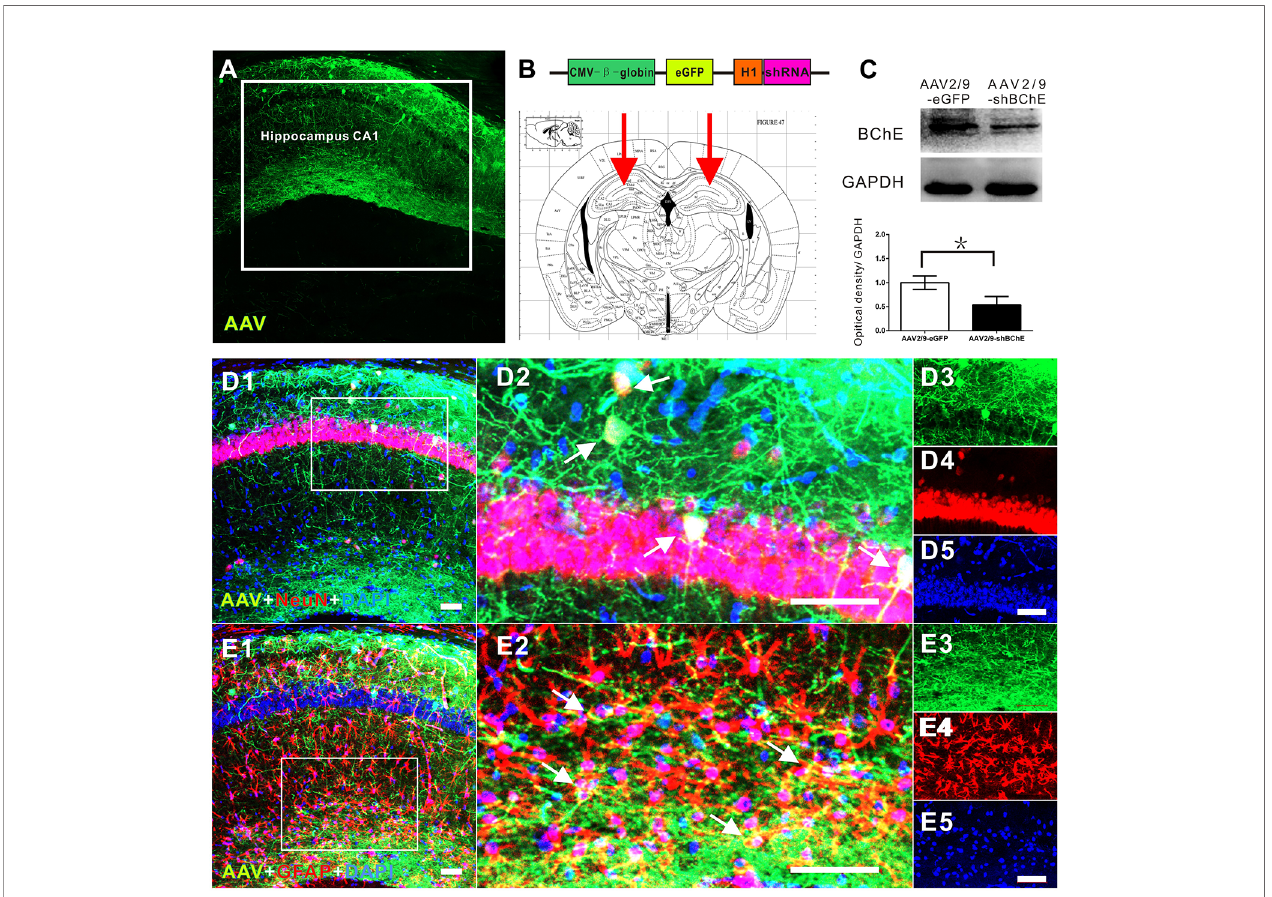
FIGURE 2 | In vivo validation of decreased BChE expression induced by the BChE AAV vector. (A) Representative brain microsections showing AAV2/9-shBChE injection sites with and eGFP expression in the hippocampus CA1 region 3 weeks after injection. Scale bar: 100 µm. (B) Schematic of the shRNA-encoding AAV vector (top) and the injection site in the hippocampus CA1 region (bottom, representative mouse brain section, 2.0 mm AP from bregma). (B) AAV2/9-shBChE CMV, CMV immediate early promoter; b -globin, human b -globin intron; H1, H1 promoter. (C) Western blots for BChE. Animals were injected with either the AAV2/9- shBChE or control AAV2/9-eGFP vector (0.5 m l, 3×10 11 vg/ml) into the unilateral hippocampal CA1 area. BChE shRNA induced robust deletion of endogenous BChE ( *p < 0.05). (D) D1 is a representative brain microsections showing colocalization of BChE shRNA (eGFP) and NeuN (yellow) in the hippocampal CA1 region. D2 is a magni fi ed image of the white box in D1. Single staining in D2 is shown on the right. AAV2/9-shBChE (green), NeuN (red) and DAPI (blue) are shown. (E) E1 are representative brain microsections showing colocalization of BChE shRNA (eGFP) and GFAP (yellow) in the hippocampal CA1 region. E2 is a magni fi ed image of the white box in E1. Single staining in E2 is shown on the right. AAV2/9-shBChE (green), GFAP (red), and DAPI (blue) are shown. Scale bar: 50 µm. The data are presented as the mean ±